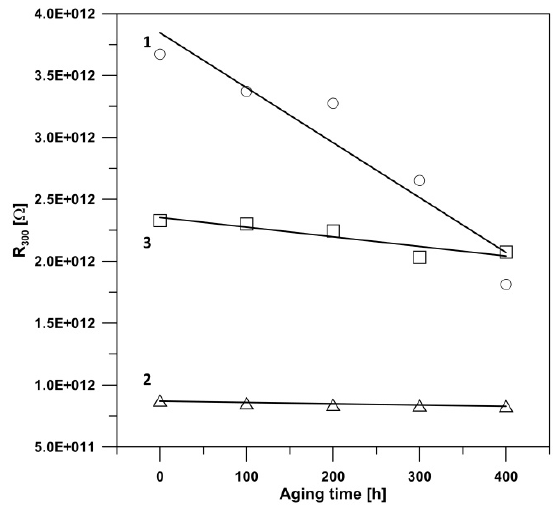
Figure 9. The influence of the thermal degradation degree of the aramid paper fibers on resistance of the insulation sample at 20 °C measured after 300 s: 1—mineral oil, 2—synthetic ester, 3—natural ester.